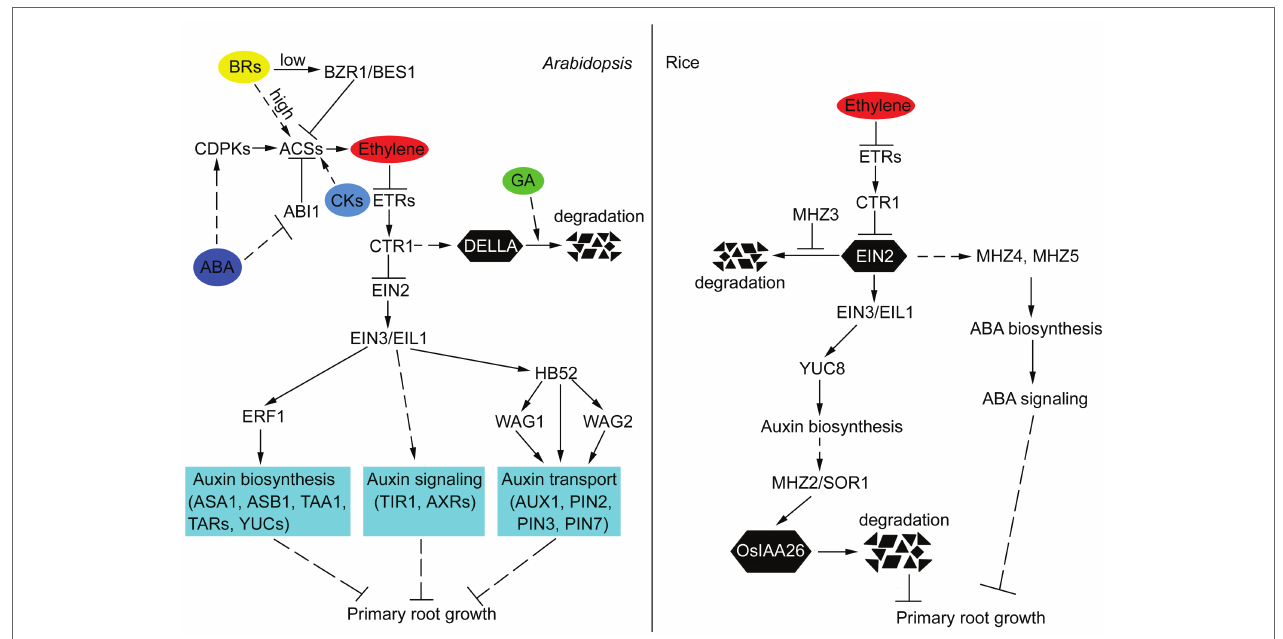
FIGURE 1 | Crosstalk of ethylene and other hormones in the primary root growth of Arabidopsis and rice. In Arabidopsis , ethylene inhibits primary root growth by regulating auxin biosynthesis, transport, and signaling. EIN3/EIL1, ERF1, and HB52 function as crosstalk nodes between ethylene and auxin in this process. ABA promotes ethylene biosynthesis by affecting the posttranscriptional regulation of ACS. GA and ethylene antagonistically regulate the stability of DELLA proteins, which act as growth repressors. CKs induce ethylene biosynthesis by stabilizing ACS stability. Low concentrations of BRs inhibit ethylene biosynthesis by activating BZR1 and BES1 to repress the expression of ACSs . High levels of BRs induce ethylene biosynthesis through increasing the stability of ACSs. In rice, ethylene restricts primary root growth by increasing auxin and ABA biosynthesis. Auxin accumulation promotes SOR1-mediated degradation of OsIAA26, thus repressing normal root growth. MHZ3 stabilizes OsEIN2 to facilitate ethylene signal transduction. The solid lines indicate direct interactions, and the dashed lines indicate indirect interactions. The arrows indicate stimulatory effects, whereas the T sharp symbol indicates inhibitory